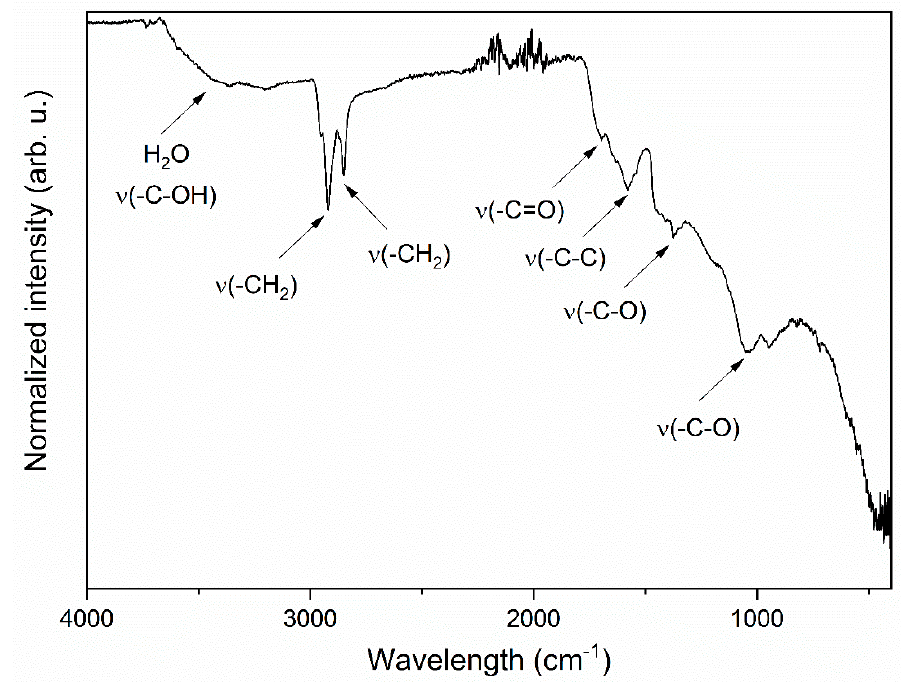
Figure 4. IR spectrum of graphene oxide material. The arrows showed vibration of particular functional groups.